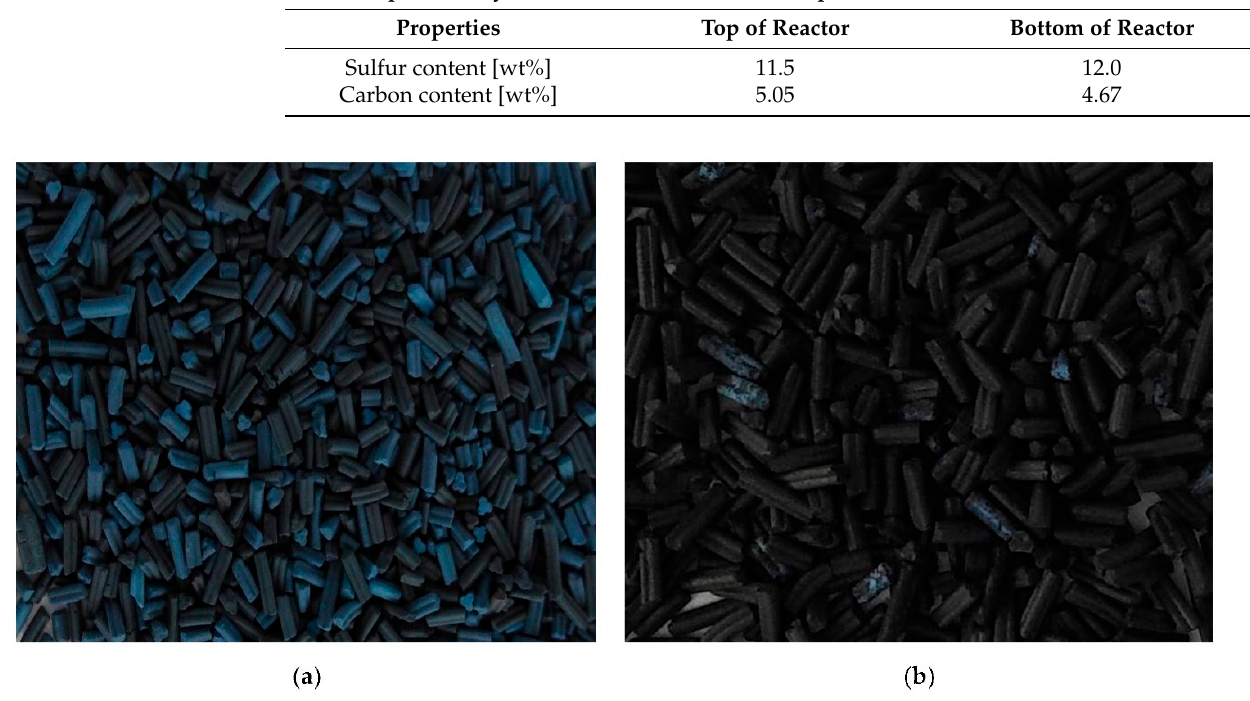
Figure 19. ( a ) Photo of fresh catalyst. ( b ) Photo of spent catalyst. Table 5. Comparison of the results of the spent catalyst.